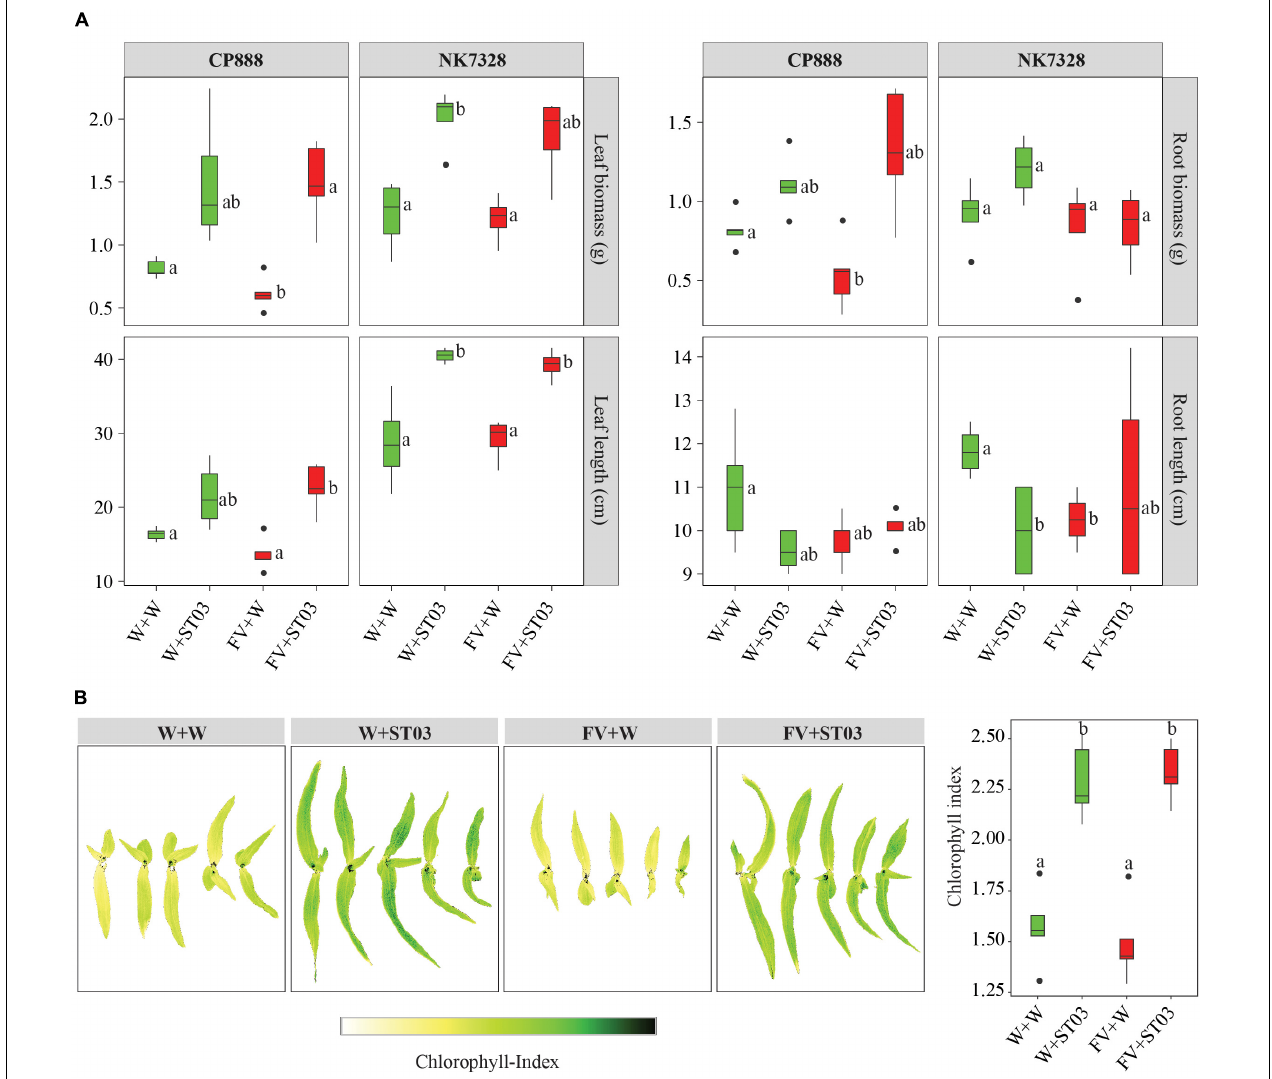
FIGURE 6 | (A) Impact of the Streptomyces strain ST03 on plant growth using two hybrid maize cultivars CP888 and Bt/GT NK7328 at 14 days after planting. (B) Chlorophyll level by treatments on CP888 plants. Chlorophyll content was assessed using a multispectral camera; white is a low chlorophyll index (ChlIdx) and dark green is high. F. verticillioides -infected maize seeds were planted in soil pre-inoculated with the biocontrol strain ST03 (FV + ST03) and planted in mock-inoculated with sterile water soil (FV + W); F. verticillioides non-infected maize seeds were planted in soil pre-inoculated with the biocontrol strain (W + ST03), or planted in mock soil (W + W). Different letters above each box depict the significant difference between treatments by cultivars using a Kruskal–Wallis test followed by a post hoc Dunn’s test at a significant level of α = 0.05. Five biological replicates were done per treatment. The experiment was repeated